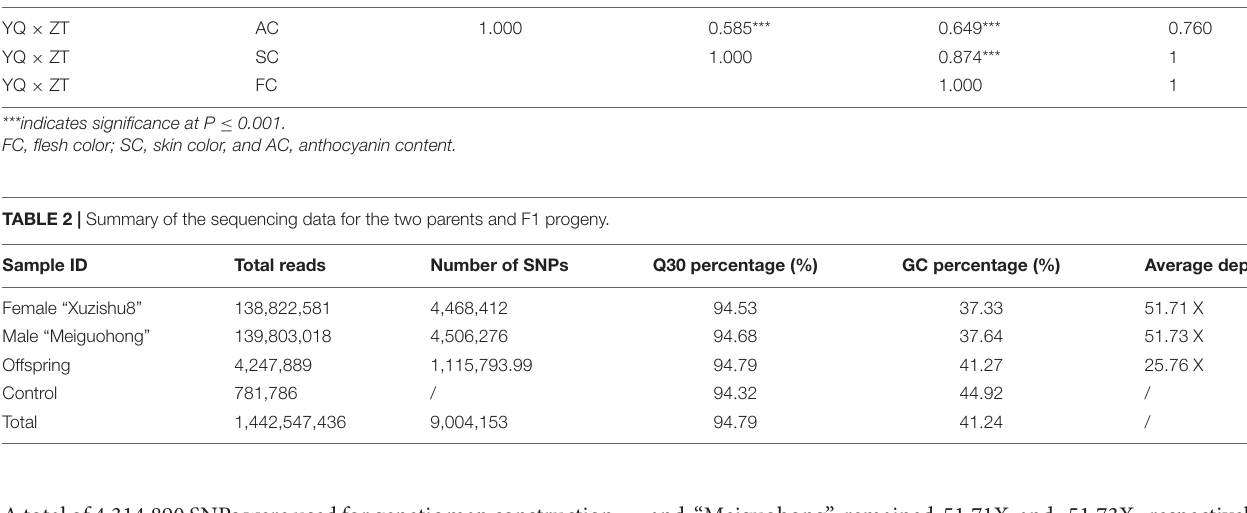
TABLE 1 | Correlation and heritability analysis of color-related traits. Trait AC SC FC H 2 by mean YQ × ZT AC 1.000 0 . 585 ***